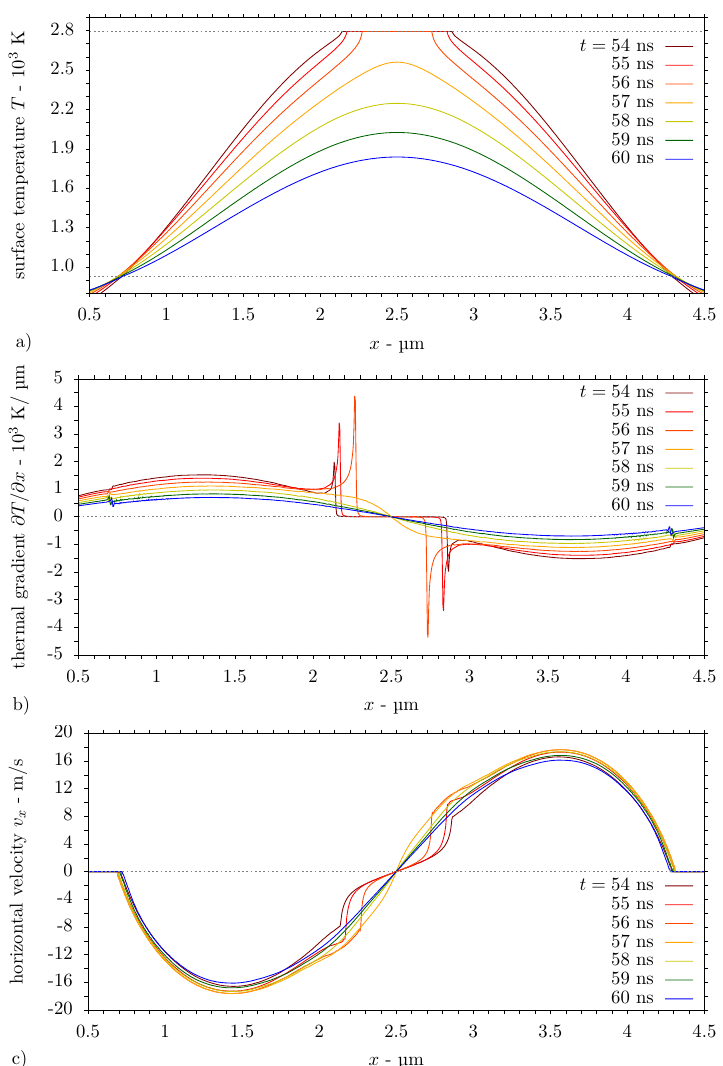
Figure 11. Evolution of ( a ) temperature, ( b ) horizontal temperature gradient and ( c ) velocity at the melt pool surface during DLIP of high-purity aluminium substrate for the laser fluence 2 Φ 0 = 1.0 J/cm 2